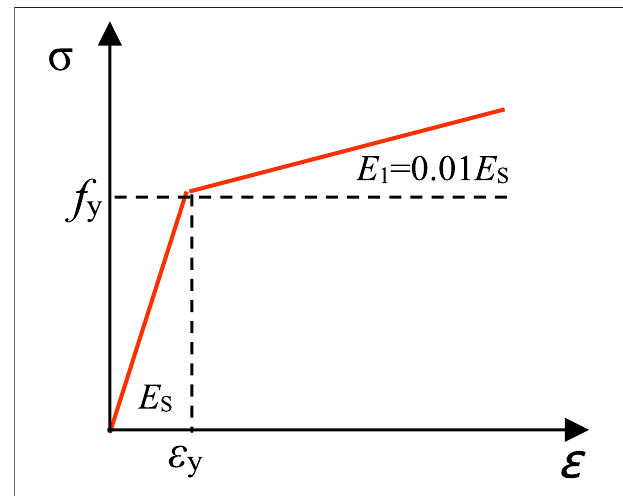
FIGURE 4 | Bilinear constitutive model of steel tube.